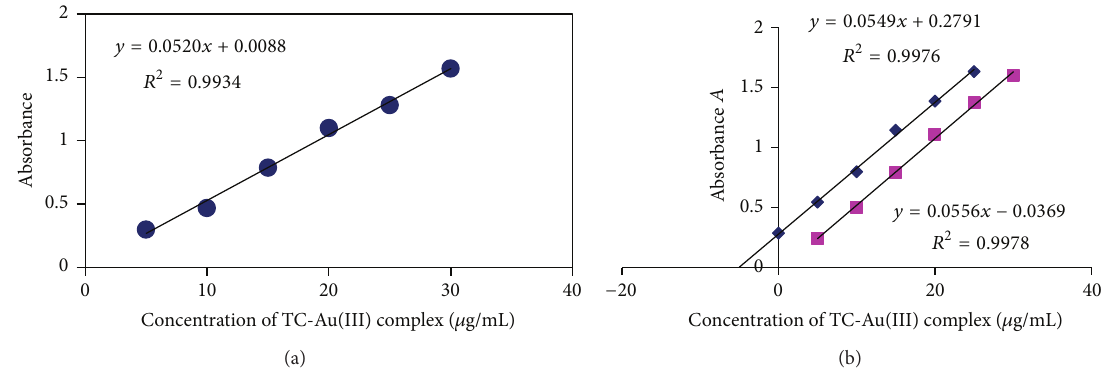
Figure 8: Direct and standard addition calibration curves for TC-Au(III) complex by FAAS.